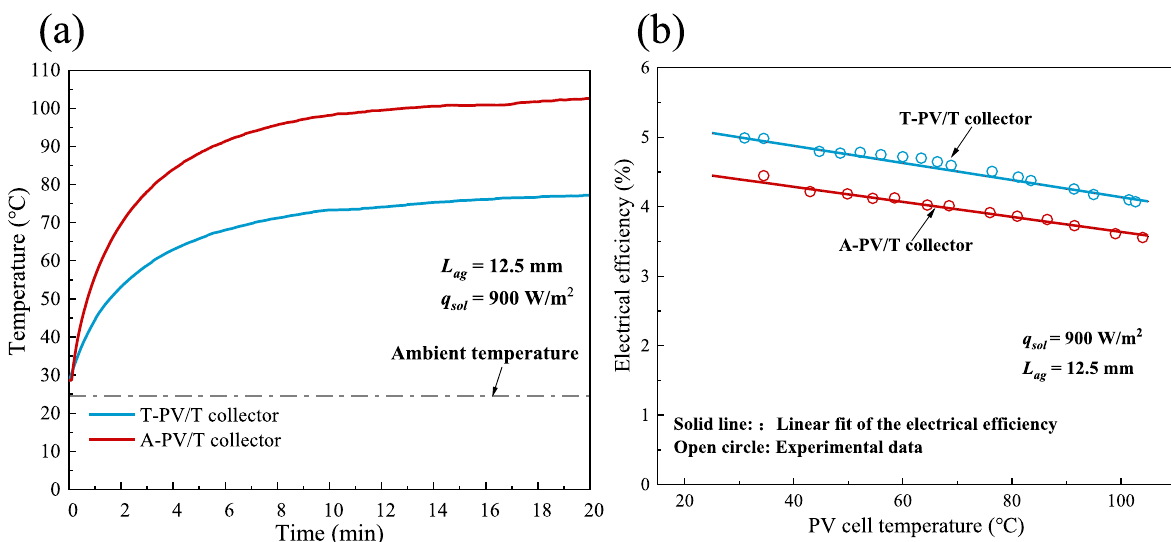
Fig. 10 Temperature and electrical efficiency of the a-Si cell. a Temperature of the a-Si cell in the A-PV/T and T-PV/T. b Electrical efficiency of the a-Si cell with silica aerogel and glass at different temperatures